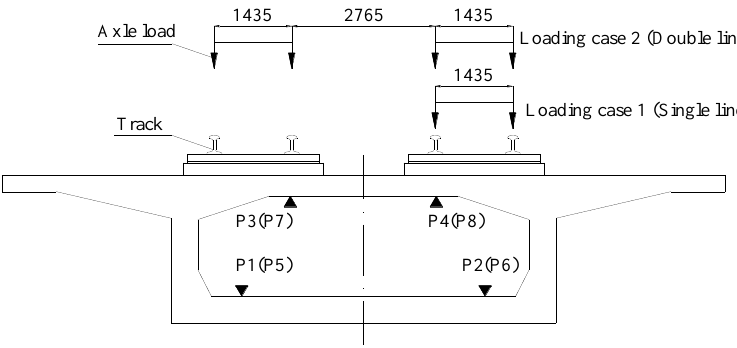
Figure 4. Loading cases of dynamic tests (unit: mm).